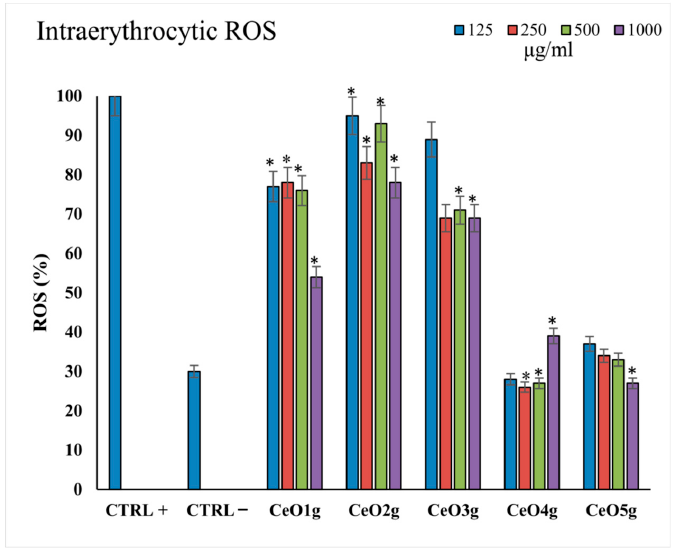
Figure 6. Intracellular ROS (%) levels after 24 h of incubation with the different CeO 2 NPs at all the tested concentrations 125–1000 μ g/mL). The lines with * above bars indicate statistically significant tested concentrations 125–1000 µ g/mL). The lines with * above bars indicate statistically significant differences ( p < 0.05) of ROS % among the positive controls treated with 10 μ M H 2 O 2 . differences ( p < 0.05) of ROS % among the positive controls treated with 10 µ M H 2 O 2